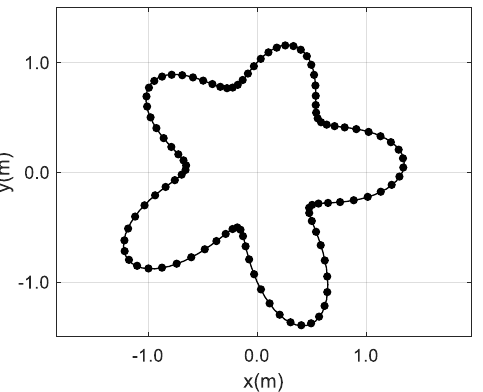
Figure 11. Geometry of the second test problem, considering a flower-shaped domain with unit particle velocity along its boundary.